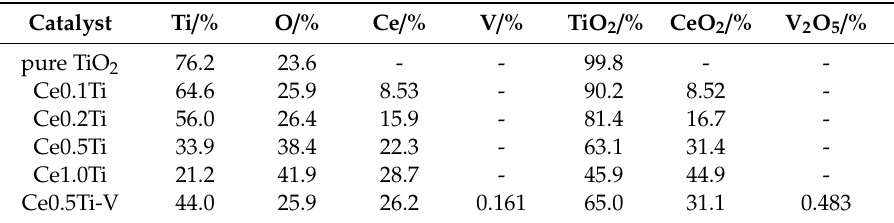
Table 4. Main compositions of the catalysts.